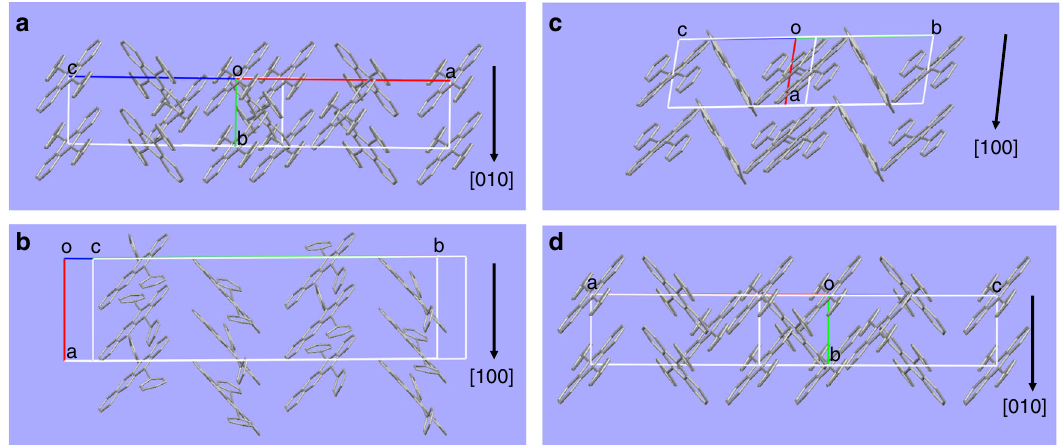
Fig. 3 Structural analysis of BA, BN, alloys c and d . a – d Molecular packing of single crystals of a BA, b BN, c alloy c and d alloy d along π - π stacking